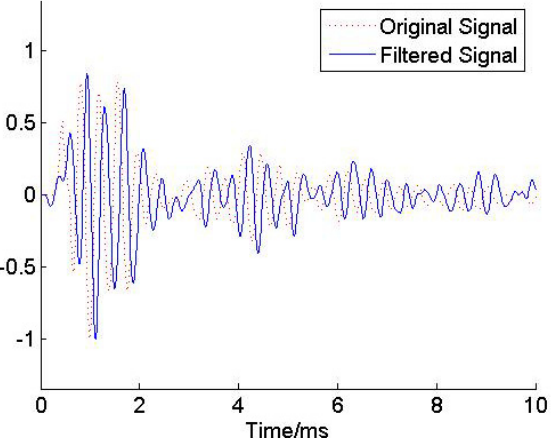
Figure 8. The denoised result using Butterworth low pass